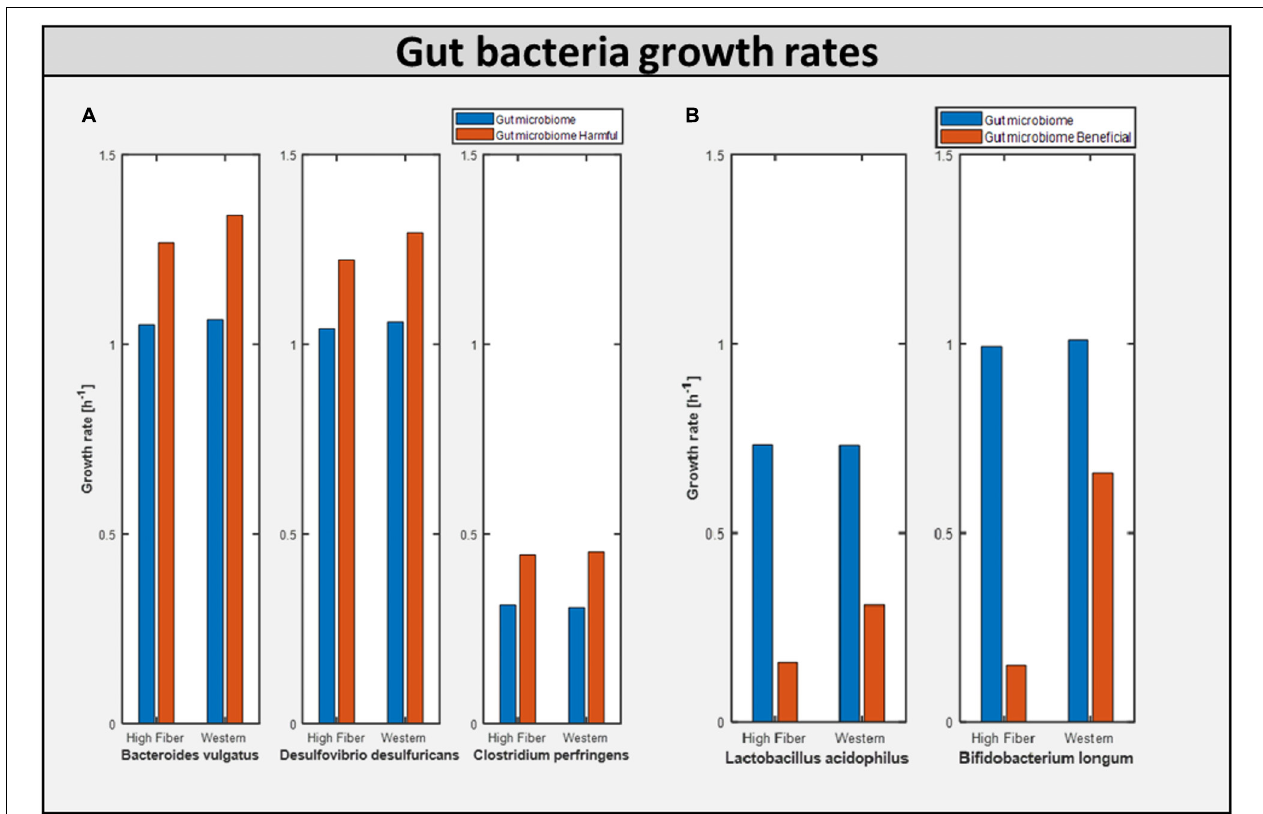
FIGURE 6 | Bacterial growth rate in differential model. (A) Growth of harmful bacteria as compared in the two model Gut microbiome and Gut microbiome harmful. (B) Growth of beneficial bacteria as compared in the two model Gut microbiome and Gut microbiome beneficial.